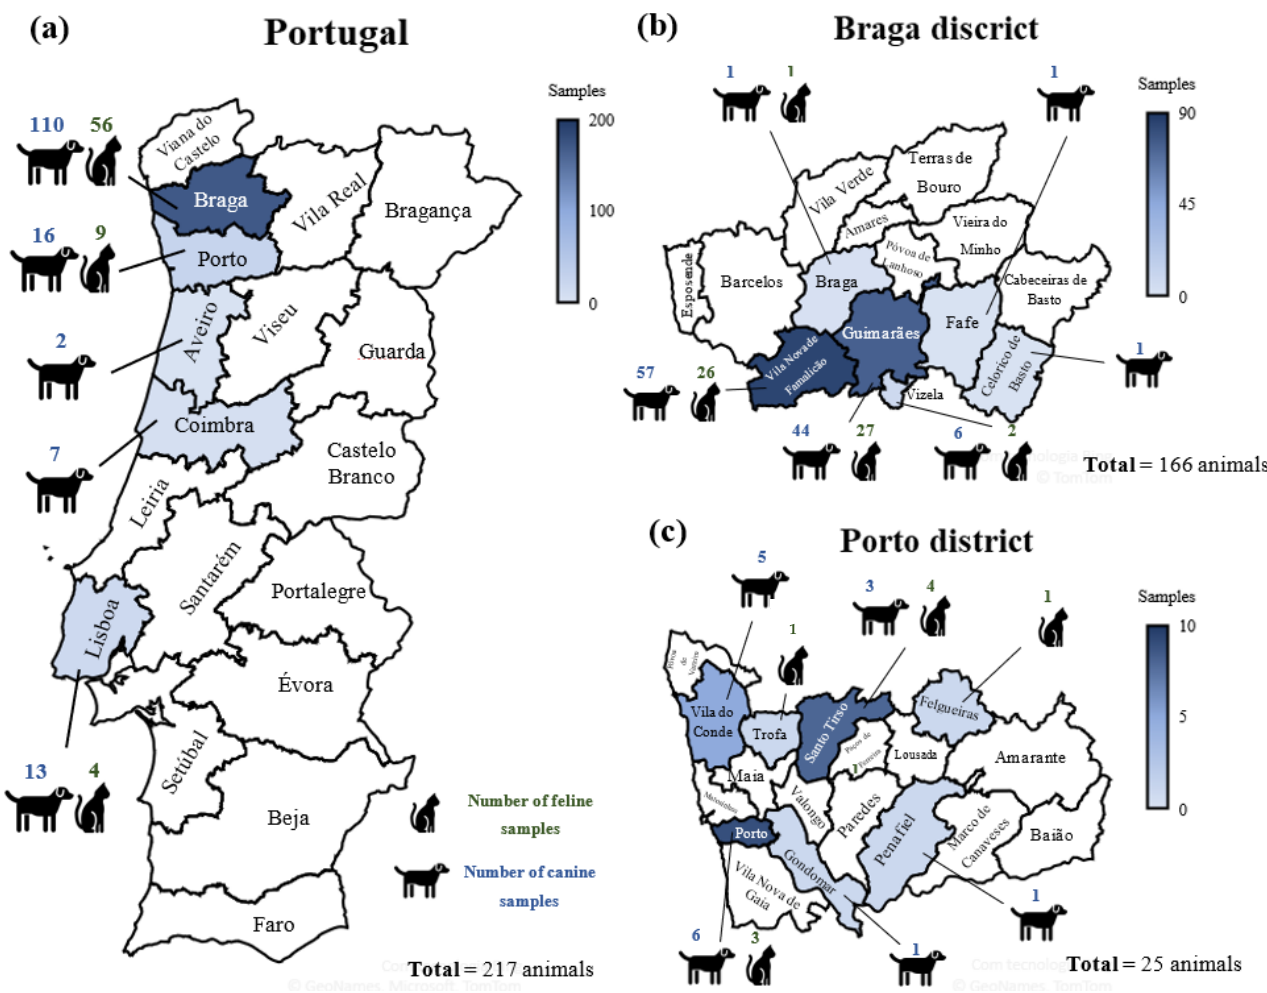
Figure 1. Geographic distribution of cat and dog samples, collected across ( a ) Portugal and in the regions of ( b ) Braga (Braga, Vila Nova de Famalicão, Guimarães, Vizela, Fafe, and Celorico de Basto as well as ( c ) Porto (Porto, Vila do Conde, Trofa, Santo Tirso, Gondomar, Felgueiras, and Penafiel).